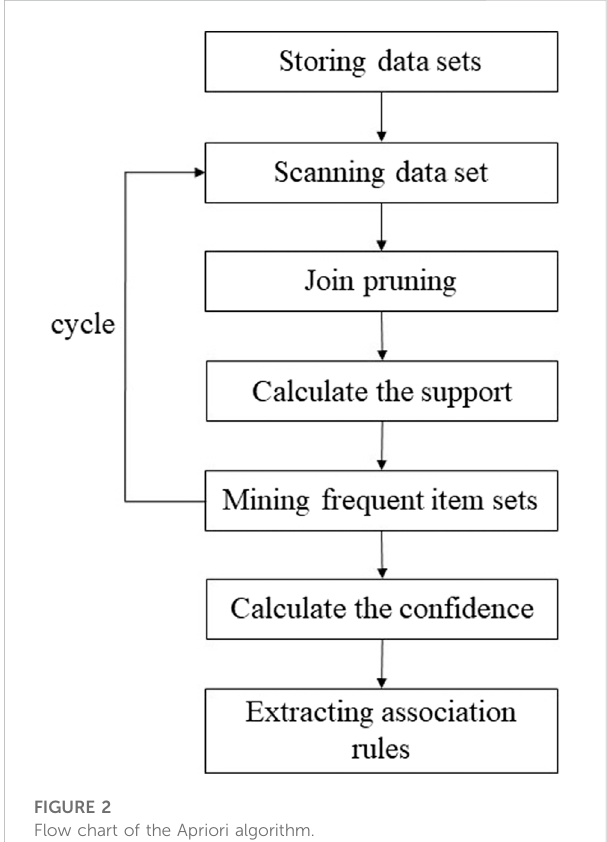
FIGURE 2 Flow chart of the Apriori